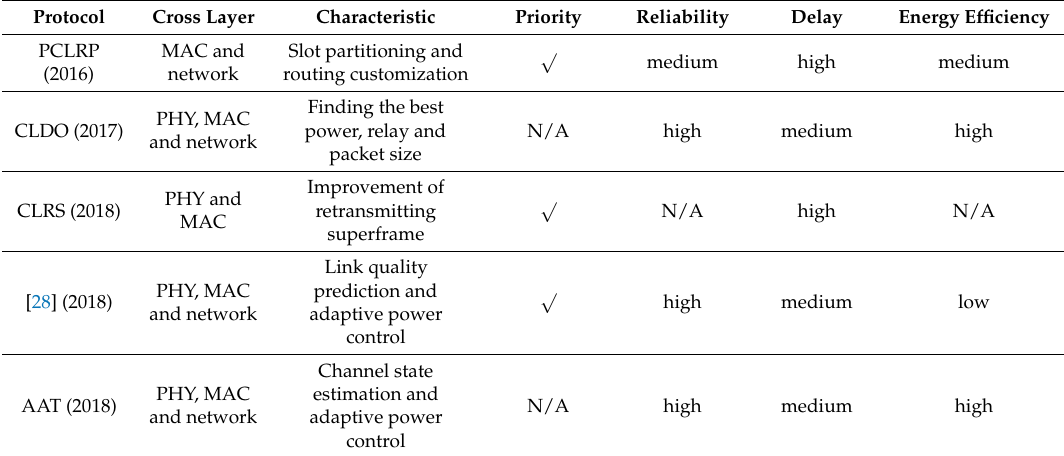
Table 4. Comparison of Cross-Layer Routing